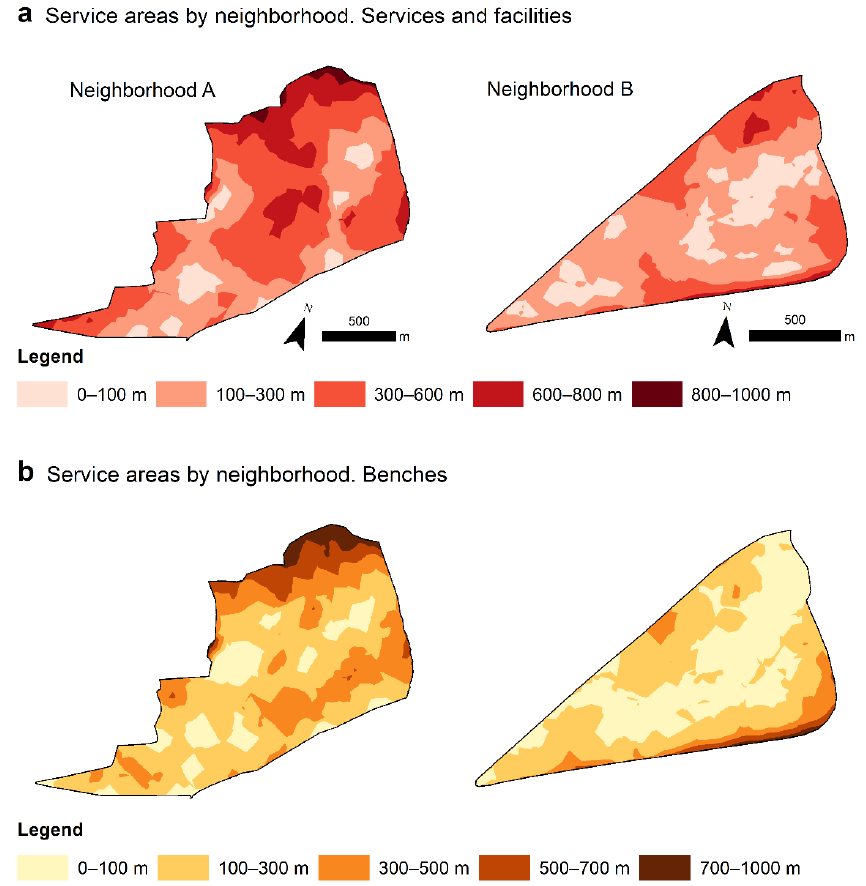
Figure 4. Service areas for “services and facilities” and “benches”. Maps created by the authors with ArcGIS 10.4 and its Network Analyst extension (https://www.esri.com/fr-fr/store/extensions/arcgis-network-analyst, accessed on 23 July 2021).